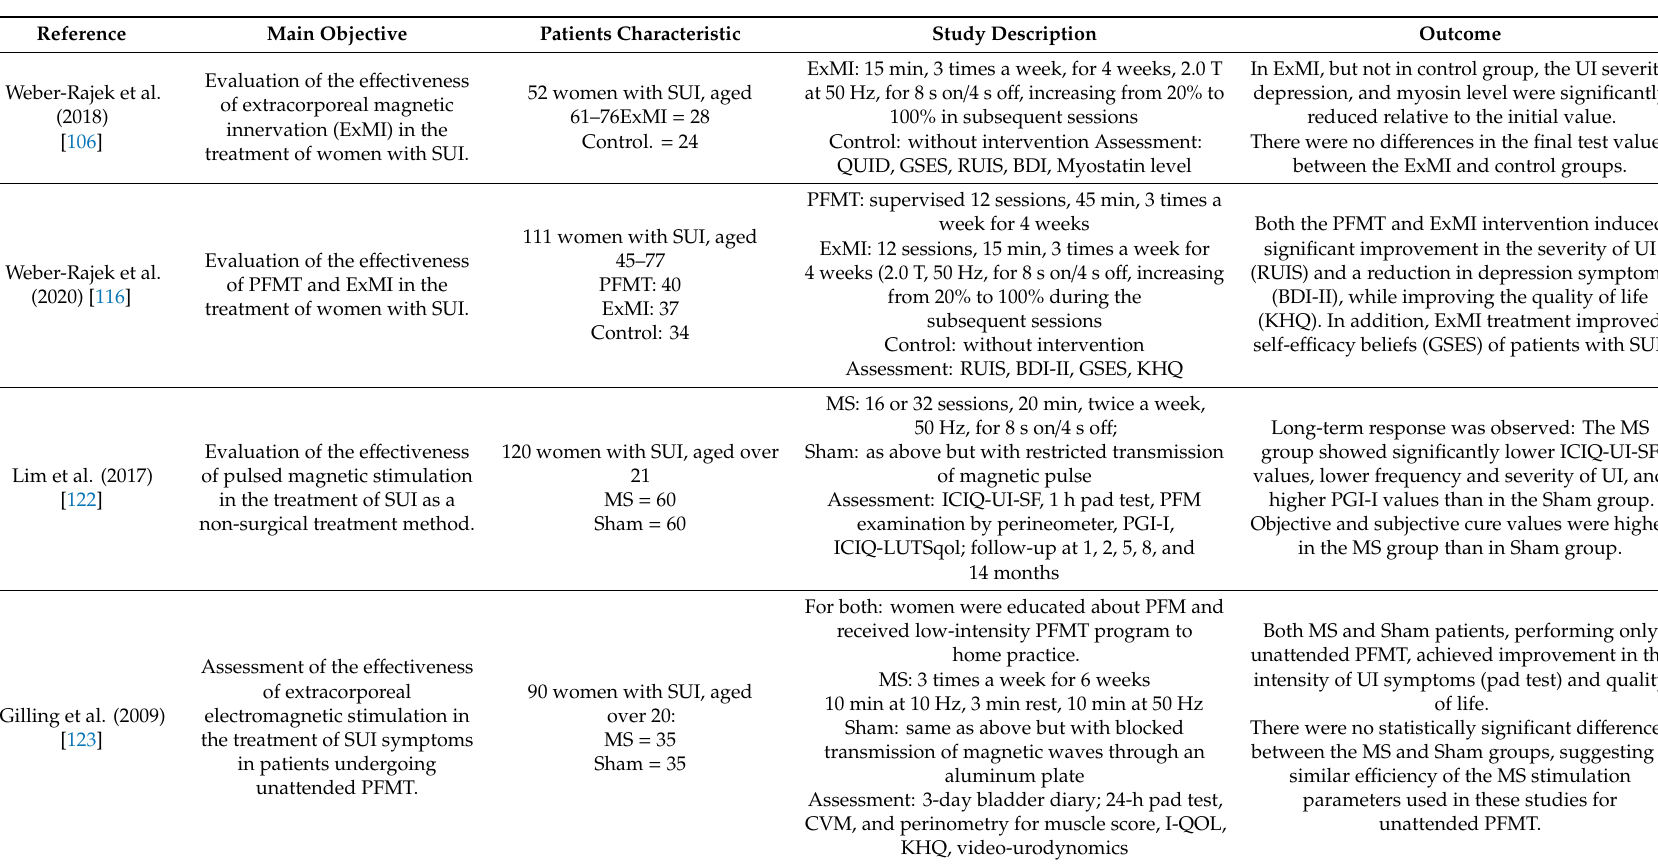
Table 4. Characteristic of selected studies on the e ff ects of magnetic stimulation on the pelvic floor muscle (PFM) activity and / or severity of urinary incontinence (UI)